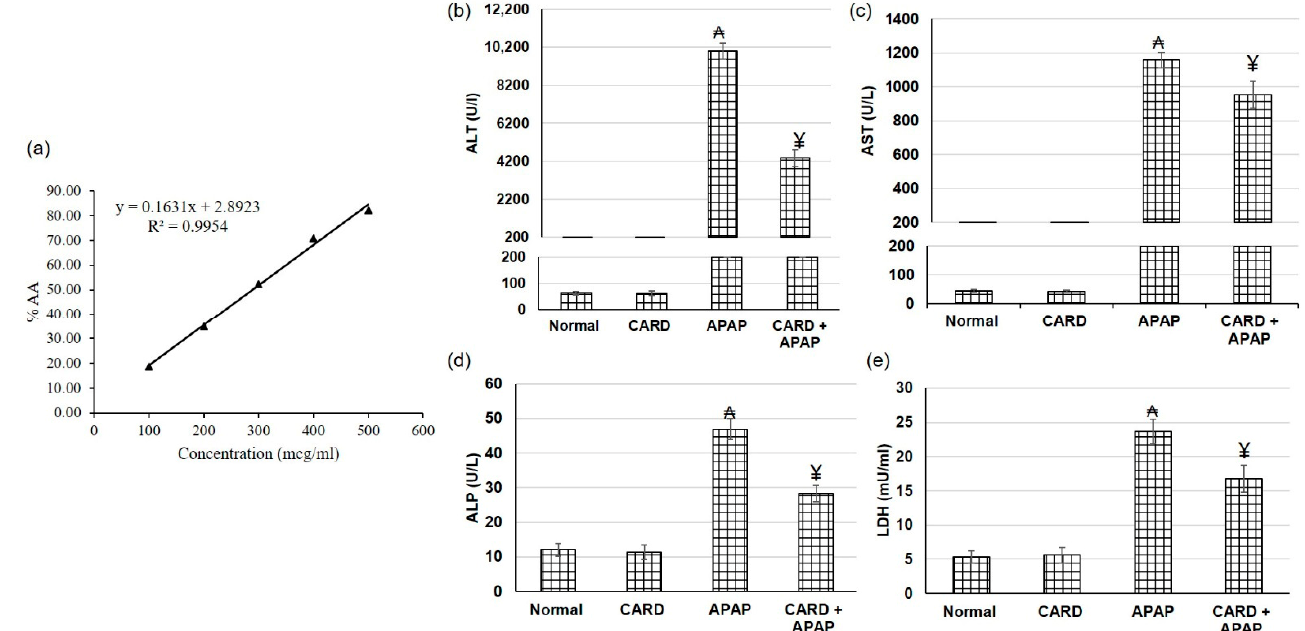
Figure 2. Effects of CARD aqueous (200 mg/kg) extract administration for 15 days prior to APAP administration (300 mg/kg) ( a ) DPPH and on the hepatic function tests, including ( b ) ALT, ( c ) AST, ( d ) ALP and ( e ) LDH in APAP induced acute hepatic failure in mice. All values are stated as mean ± SD. ₳ designates statistically significant compared to the normal group and ¥ designates statistically significant compared to the APAP group ( p < 0.05) using one-way ANOVA followed by Tukey’s post hoc test.